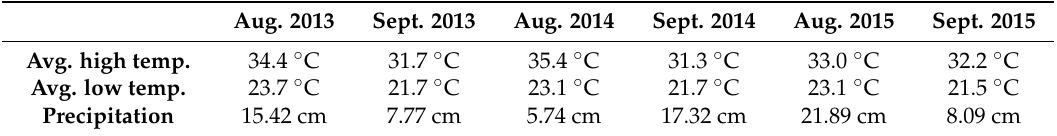
Table 7. Recorded weather data in August and September (2013–2015) when berry samples were